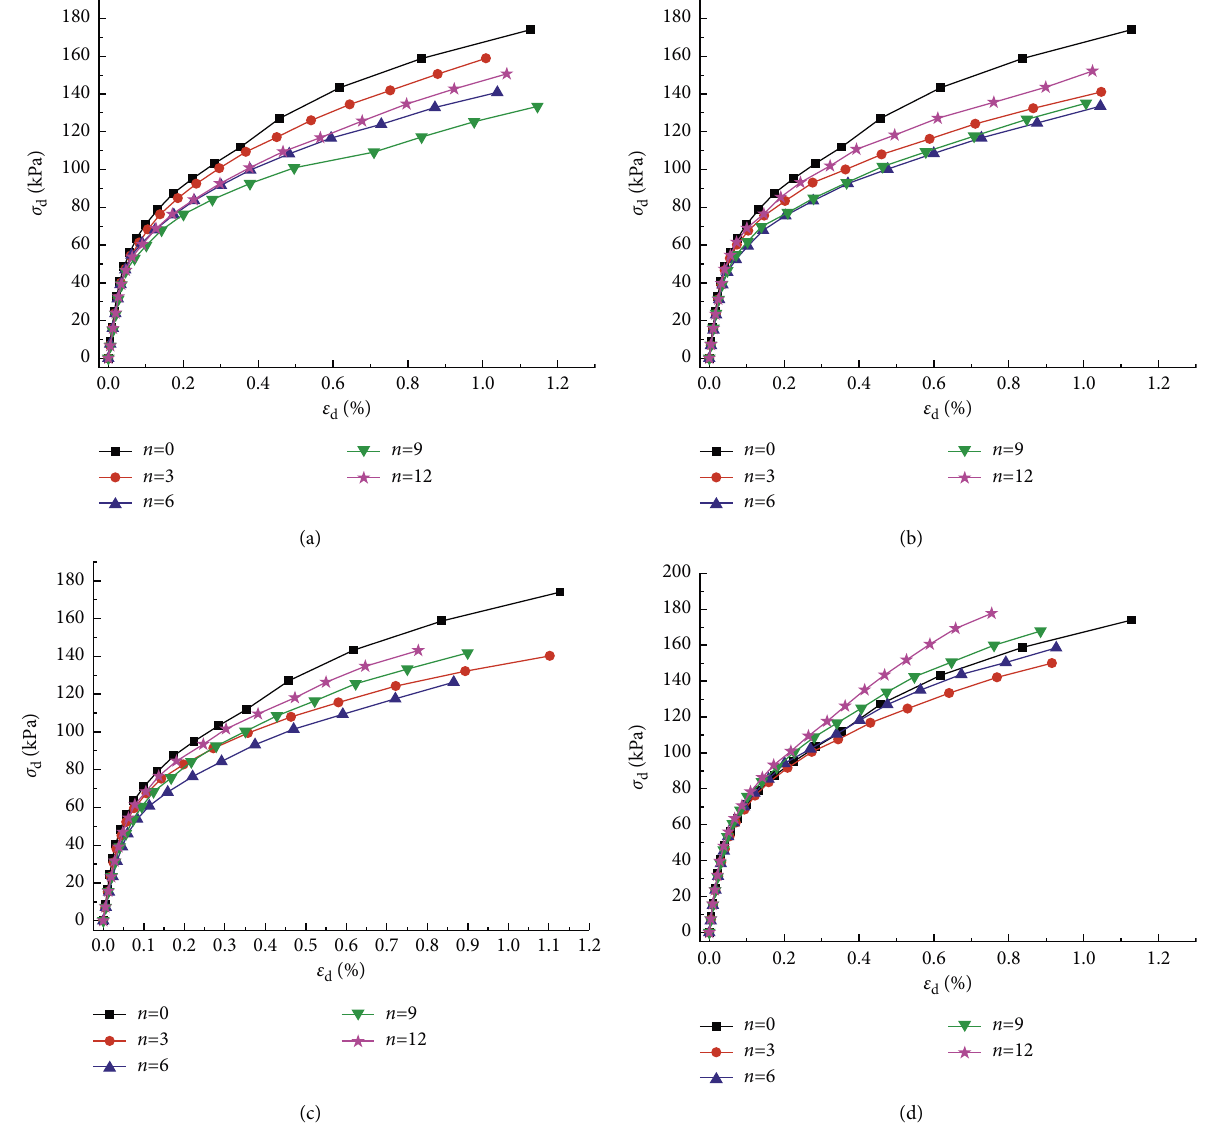
Figure 3: Dynamic stress-strain relationship of compacted loess under W - D cycles ( σ path a. (b) W - D cycle path b . (c) W - D cycle path c . (d) W - D cycle path d